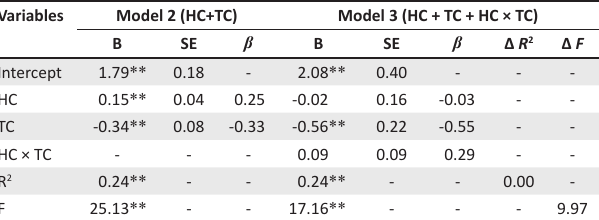
TABLE 4: Moderation effects between HC + TC + HC × TC. Variables